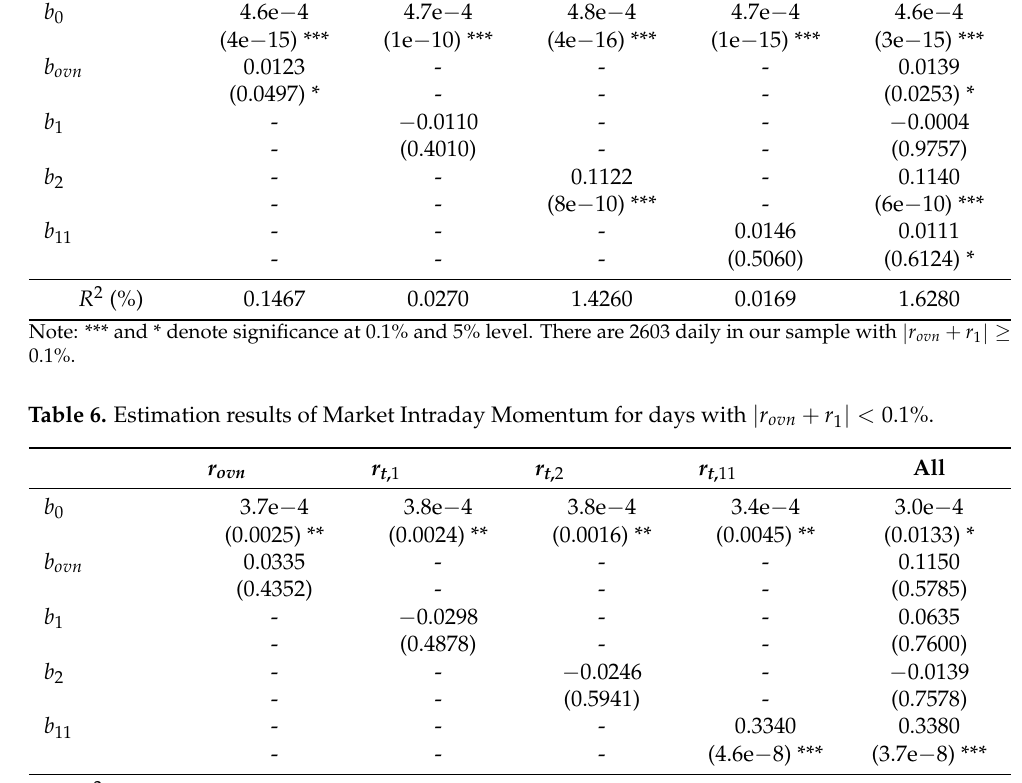
Table 5. Estimation results of Market Intraday Momentum for days with | r ovn + r 1 | ≥ 0.1%. r ovn